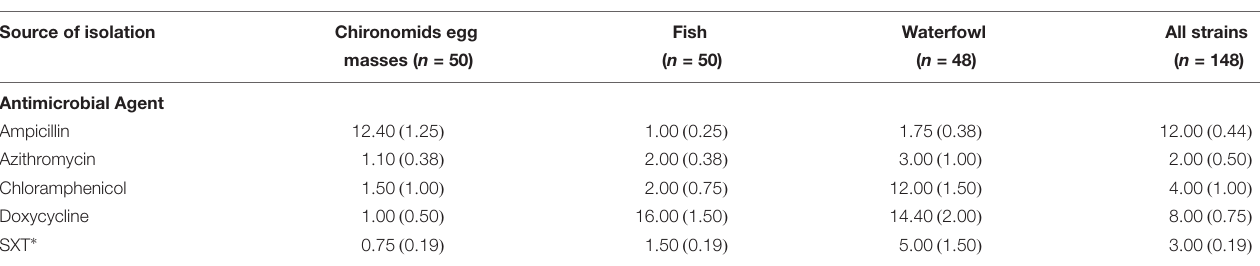
FIGURE 1 | MIC (average ± std. error) of the studied antimicrobial agents toward all V. cholerae strains. Ampicillin ( n = 146), azithromycin ( n = 141), chloramphenicol ( n = 146), doxycycline ( n = 144); SXT ( n = 146). Bars with different letters are significantly different by repeated measures ANOVA with Bonferroni post hoc test ( p < 0.05). SXT, Trimethoprim (TMP) and sulfamethoxazole. TABLE 1 | MIC 90 and MIC 50 values ( µ g/ml) for all V. cholerae